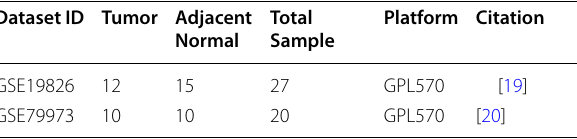
Table 1 GEO Datasets selected for comparison with the RNA sequencing data from GC patients from Mizoram Dataset ID Tumor Adjacent